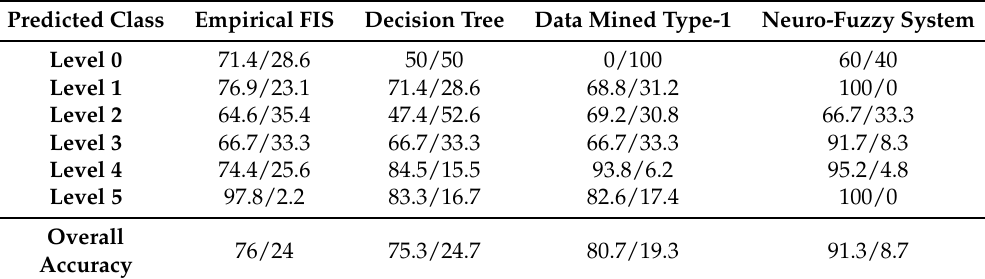
Table 2. Accuracy Percent/Error Percent for Each Predicted Class for Each